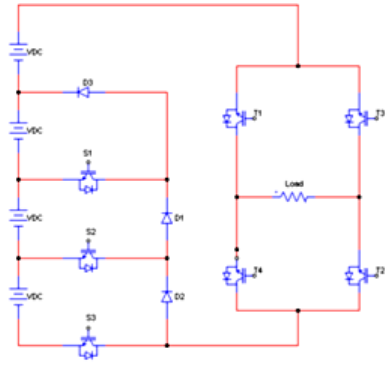
Figure 5. MLI with reduced number of switches.